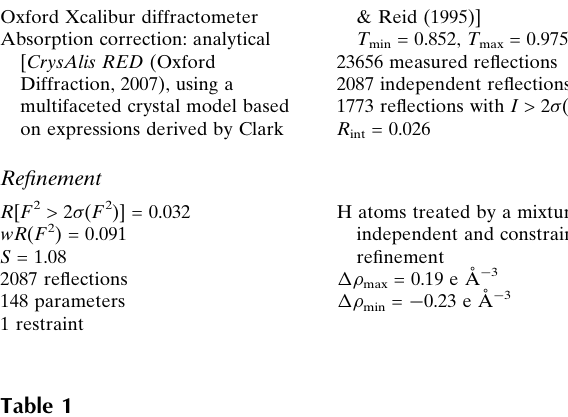
Hydrogen-bond geometry (A˚ , (cid:1)